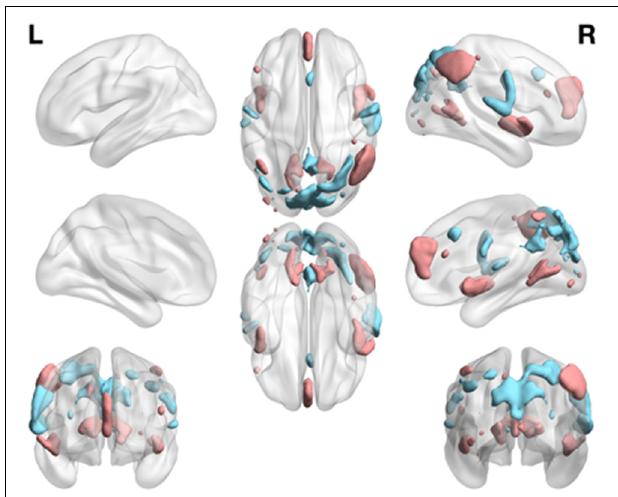
FIGURE 4 | Group differences of functional network maps between ADHD patients and HCs. It is a summary of eight functional network differences. The intersection of the RIN of the HCs and the AN of the adult ADHD; and the areas that satisfy the two-sample t -test and have significant differences are shown as cold areas. The intersection of the AN of HCs and the RIN of adult ADHD; and the areas that satisfy the significant difference of the two-sample t -test are shown as hot area. Use thresholds of p < 0.05 and µ = 3 to display clusters. L, left hemisphere; R, right hemisphere. HC, healthy control; ADHD, attention deficit hyperactivity disorder; RIN, relatively inert network; AN, activation network.